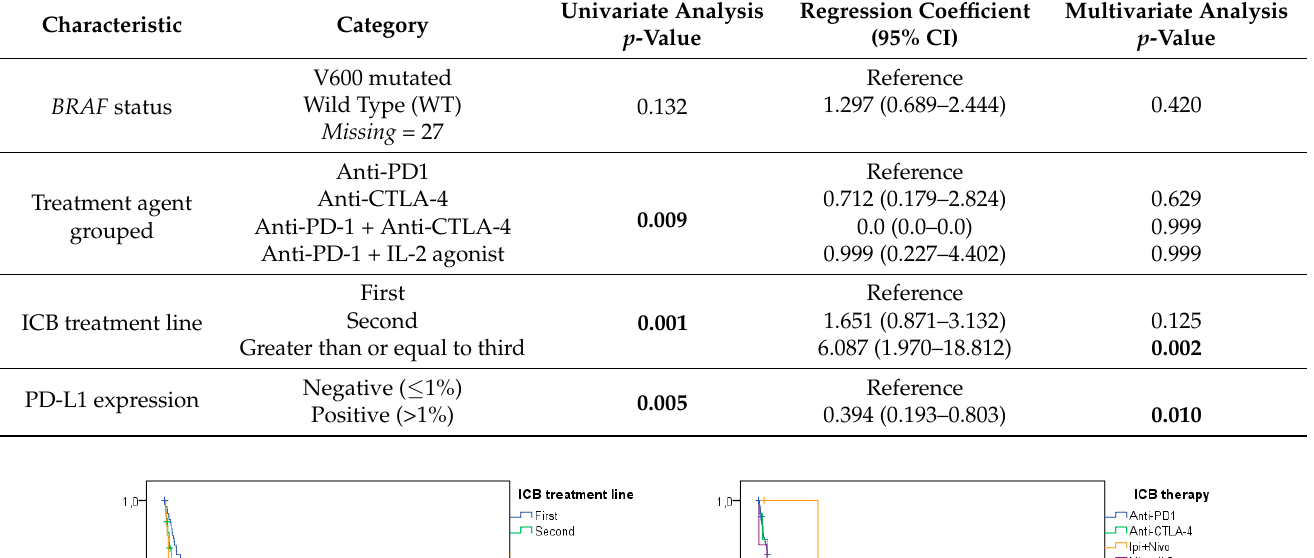
Table 3. Univariate and multivariate analyses evaluating the effect of clinical and molecular features on the therapeutic response of advanced melanoma patients treated with ICB.